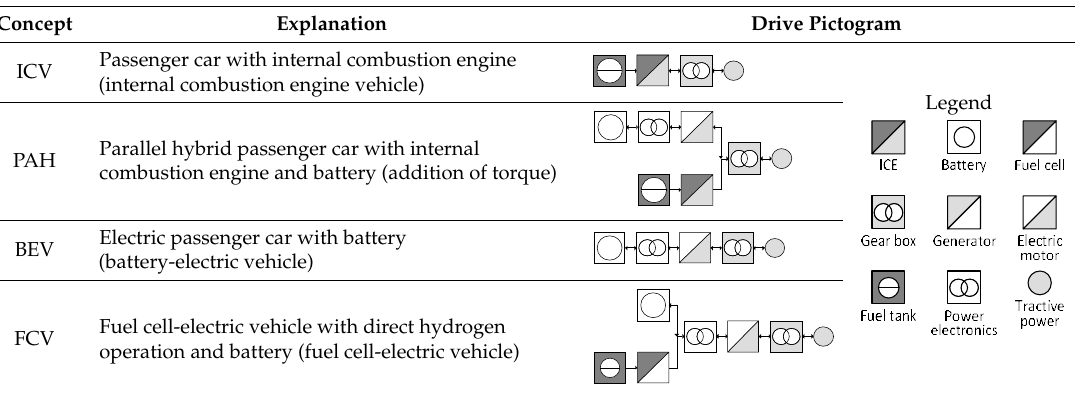
Table 2. Passenger car concepts and drive topologies. The pictograms of the drive topologies include only the main energy flows of the drive; auxiliary consumers are disregarded in this representation. Symbols are adapted from Isermann [23].